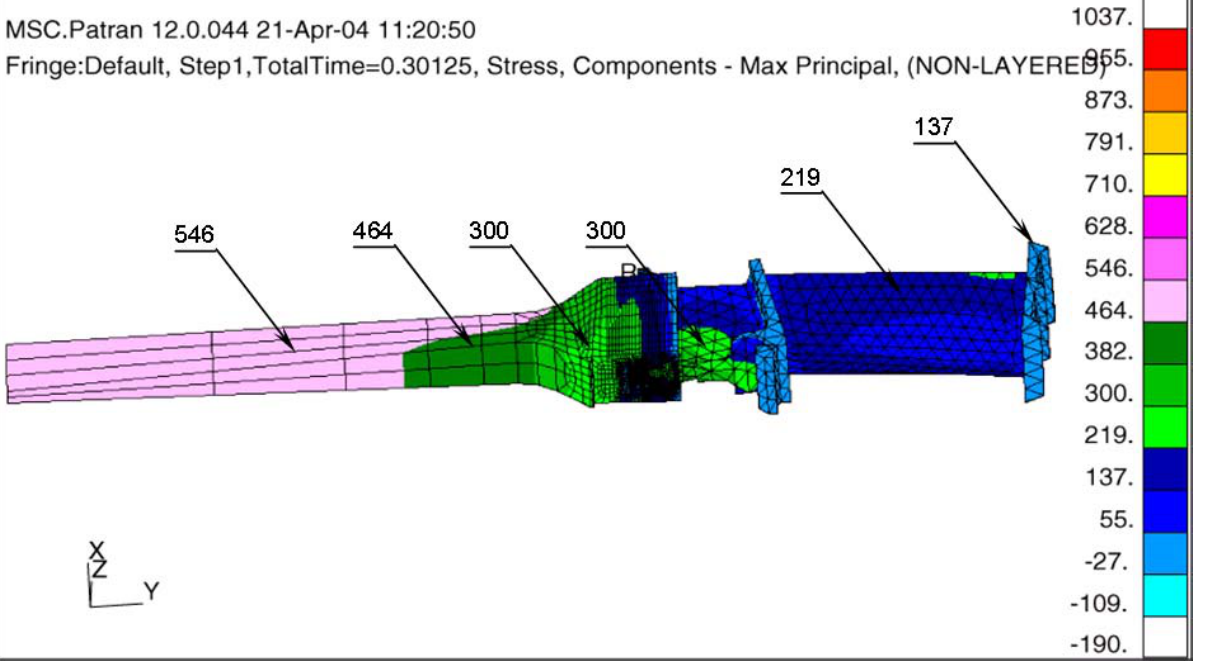
Fig 6 . Maximum principal stress distribution of turbine segment under spin rig